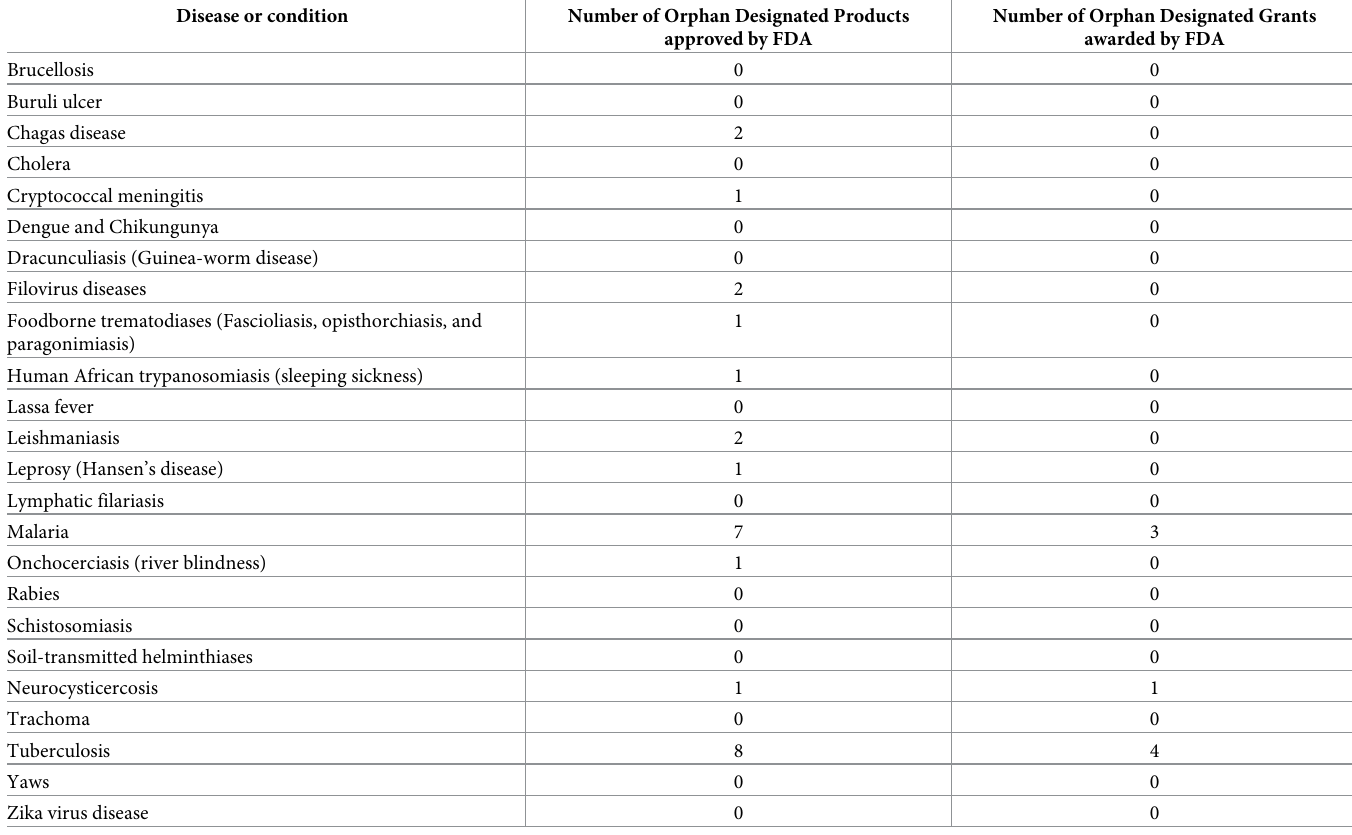
Table 2. Number of products and grants approved by FDA as part of the Orphan Products Designation Program and the Orphan Products Grant Program, respectively. Disease or